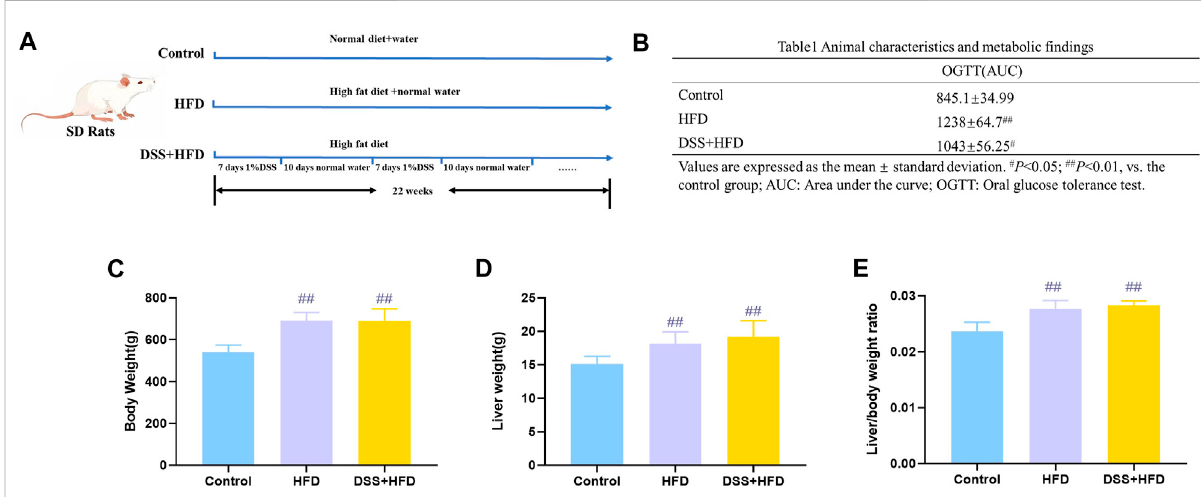
FIGURE 1 Metabolism of rats during modeling. (A) Methodology fl ow chart. (B) Body weight. (C) Liver weight. (D) Liver/body weight ratio. Values are means ± SD ( n = 4 – 6). Control: standard chow; HFD: high fat diet; DSS + HFD: high fat diet +1% DSS in drinking water. # p < 0.05, ## p < 0.01, vs. the control